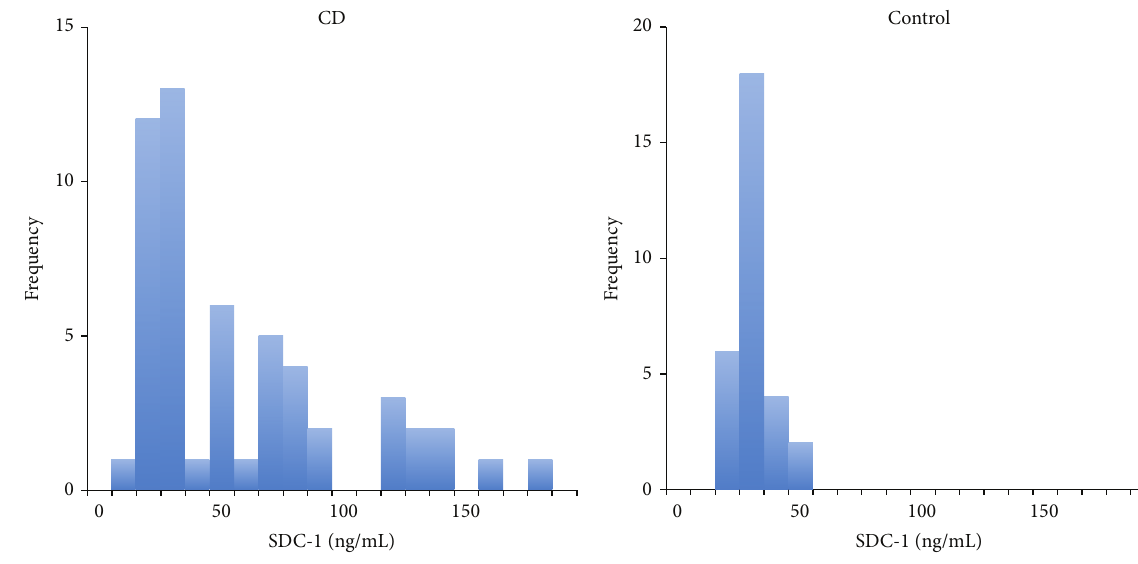
Figure 1: Histograms of serum SDC-1 levels of the patients with Crohn’s disease and control group.